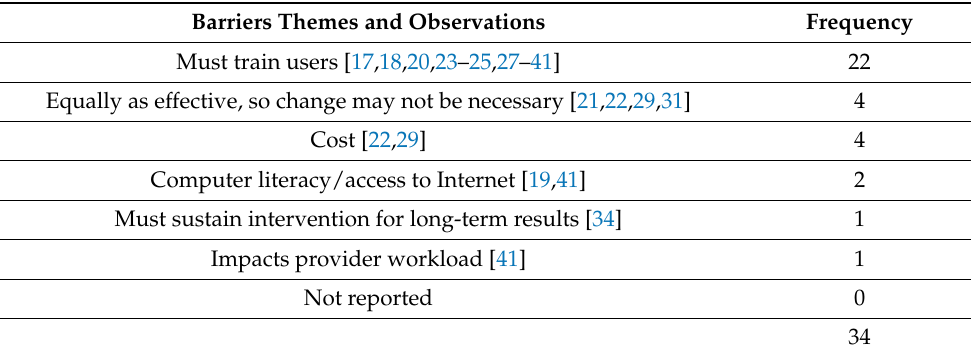
Table 6. Barrier themes and